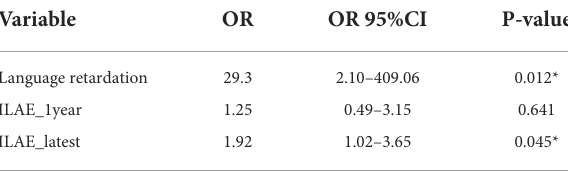
TABLE 3 Multivariate logistic regression models showing the variables independently associated with the meaningful changes in QoL in children with residual seizure after resection